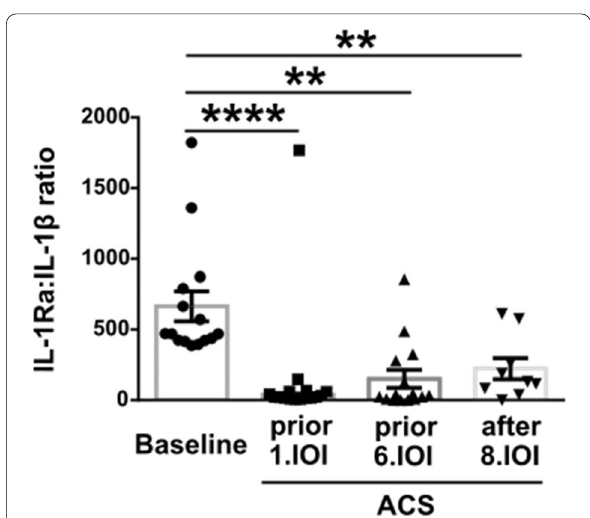
Fig. 2 Ratio of IL-1Ra to IL-1β detected using ELISA in a total of 15 patients. Shown is the mean SE. Statistical analyses were carried ± out as described in the method section. IOI intravenous oxygen = insufflation; ACS autologous conditioned =